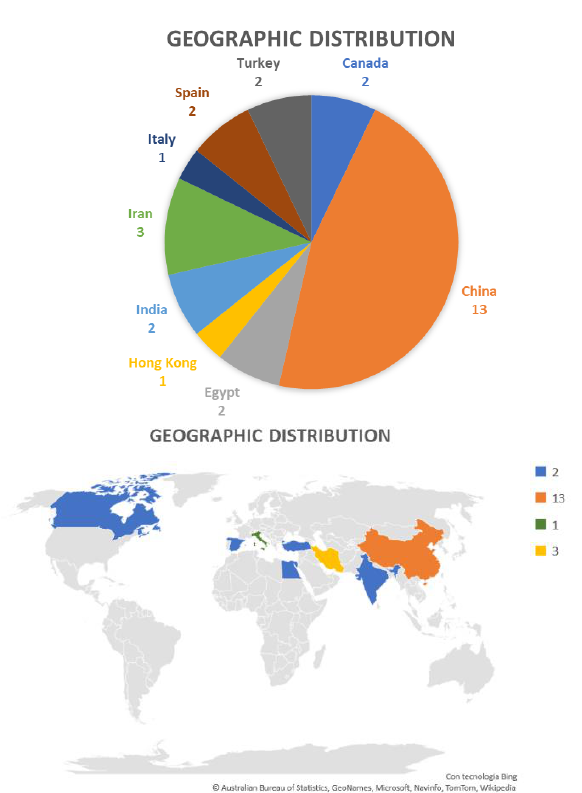
Figure 4 . Geographic distribution of the applicants of both WG III/5 Data Sets.